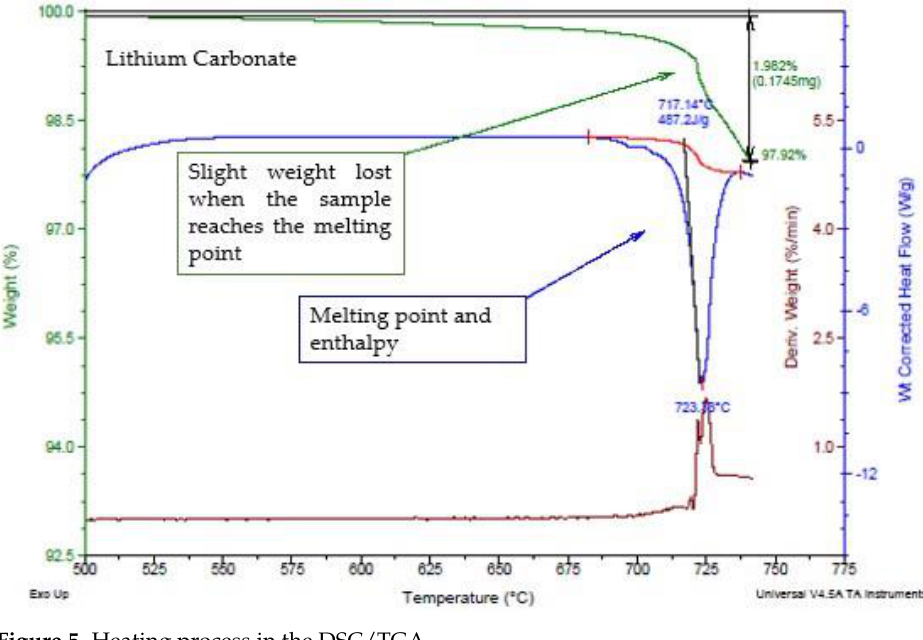
Figure 5. Heating process in the DSC/TGA.